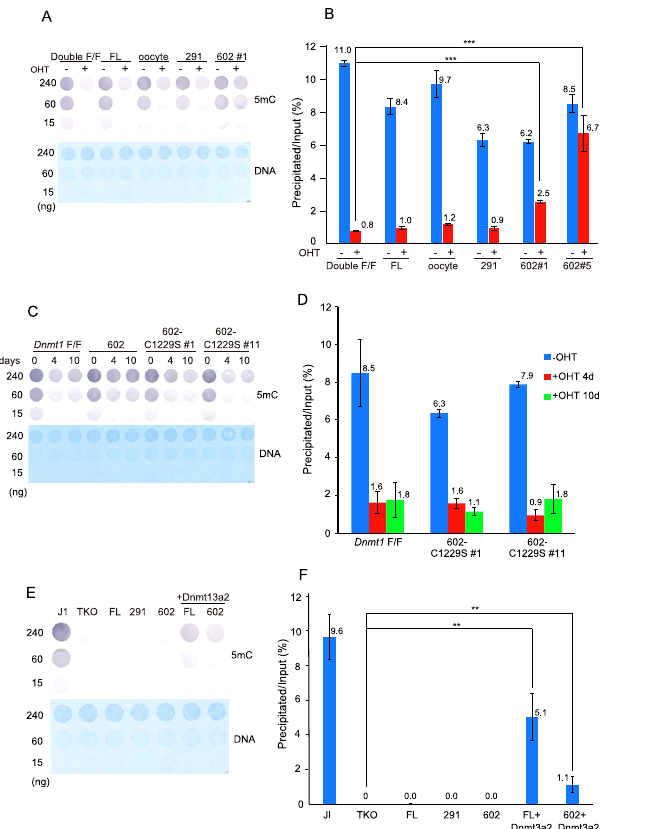
Fig 6. Global DNA methylation of Dnmt1 and Uhrf1 double-knockout, or TKO ESC expressing ectopic Dnmt1. ( A ) Genome DNA prepared from Dnmt1 and Uhrf1 conditional double-knockout ESC expressing either no ectopic Dnmt1 (Double F/F), or full-length Dnmt1 (FL), oocyte-type Dnmt1 (oocyte), Dnmt1(291 – 1620) (291), or Dnmt1(602 – 1620) clone #1 (602#1) treated without (-) or with OHT (+) for ten days was immuno-blotted with anti-methylated cytosine antibody (5mC, upper panel) or stained with methylene blue (DNA, lower panel). The amounts of DNA are shown at the left. ( B ) The genome DNA in panel A and Dnmt1 (602 – 1620) clone #5 (602#5) were fragmented by sonication, and then precipitated with MBD1. The precipitated DNA was quantitated as in Fig 1D, averages ± S. D. being shown. *** , p < 0.001. ( C ) Genome DNA prepared from Dnmt1 conditional-knockout ESC expressing either no ectopic Dnmt1 ( Dnmt1 -F/F), Dnmt1(602 – 1620), Dnmt1(602 – 1620) with C1229S clones#1 (602-C1229S #1), or clone #11 (602-C1229S #11) treated without (0) or with OHT for four days (4) or ten days (10) was immuno-blotted with anti- methylated cytosine antibody (5mC, upper panel), or stained with methylene blue (DNA, lower panel). The amounts of DNA are shown at the left. ( D ) Genome DNA prepared from Dnmt1 conditional-knockout ESC expressing either no ectopic Dnmt1 ( Dnmt1 -F/F), or Dnmt1(602 – 1620) with C1229S clone #1 (602-C1229S #1) or clone #11 (602-C1229S #11) treated without (blue) or with OHT for four days (red) or ten days (green) was fragmented by sonication, and then precipitated with MBD1. The precipitated DNA was quantitated as in Fig 1D, averages ± S. D. being shown. ( E ) Genome DNA prepared from parent ESC (J1), TKO ESC (TKO), TKO ESC expressing full-length Dnmt1 (FL), Dnmt1(291 – 1620) (291), Dnmt1(602 – 1620) (602), full-length Dnmt1 and Dnmt3a2-TAP (FL+Dnmt3a2), or (602 – 1620) and Dnmt3a2-TAP (602+Dnmt3a2) was immuno- blotted with anti-methylated cytosine antibody (5mC, upper panel), or stained with methylene blue (DNA, lower panel). The amounts of DNA are shown at the left. ( F ) Genome DNA prepared from J1, TKO ESC (TKO), TKO ESC expressing no ectopic Dnmt1 (TKO), or full-length Dnmt1 (FL), Dnmt1(291 – 1620) (291), Dnmt1(602 – 1620) (602), full-length Dnmt1 and Dnmt3a2-TAP (FL+Dnmt3a2), or Dnmt1(602 – 1620) and Dnmt3a2-TAP (602+Dnmt3a2) was fragmented by sonication, precipitated with MBD1, and then analyzed as in Fig 1D. The value obtained for TKO was considered as no DNA methylation and subtracted from each measurement. Averages ± S. D. are